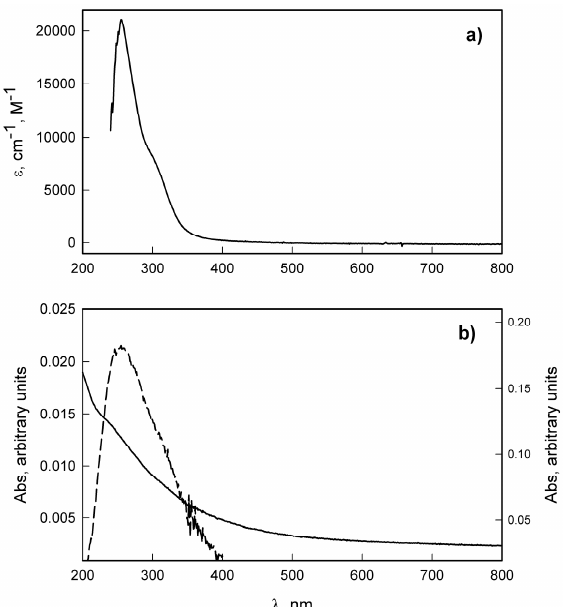
Figure 1. ( a ) UV-Vis spectrum of a 10 − 4 M solution of Ag-SDM in water/DMSO in a quartz cuvette, ( b ) UV-Vis spectrum of SURF-Ag-SDM i.e., a quartz slide coated with a SAM of Ag-SDM (solid line, absorbance on the right axis). The dashed spectrum (absorbance on the left axis) is obtained after background subtraction (the scale of the axis is smaller), in order to evidence the absorption band. In order to be able to test the antibacterial efficiency of sulfadiazine in absence of Ag + , eight -SH terminated glasses were dipped in an SDM solution, i.e., sulfadiazine maleimide in absence of silver ion. In this case, after the grafting (samples SURF-SDM), the static contact angle changed to a value of 51° (±3°).